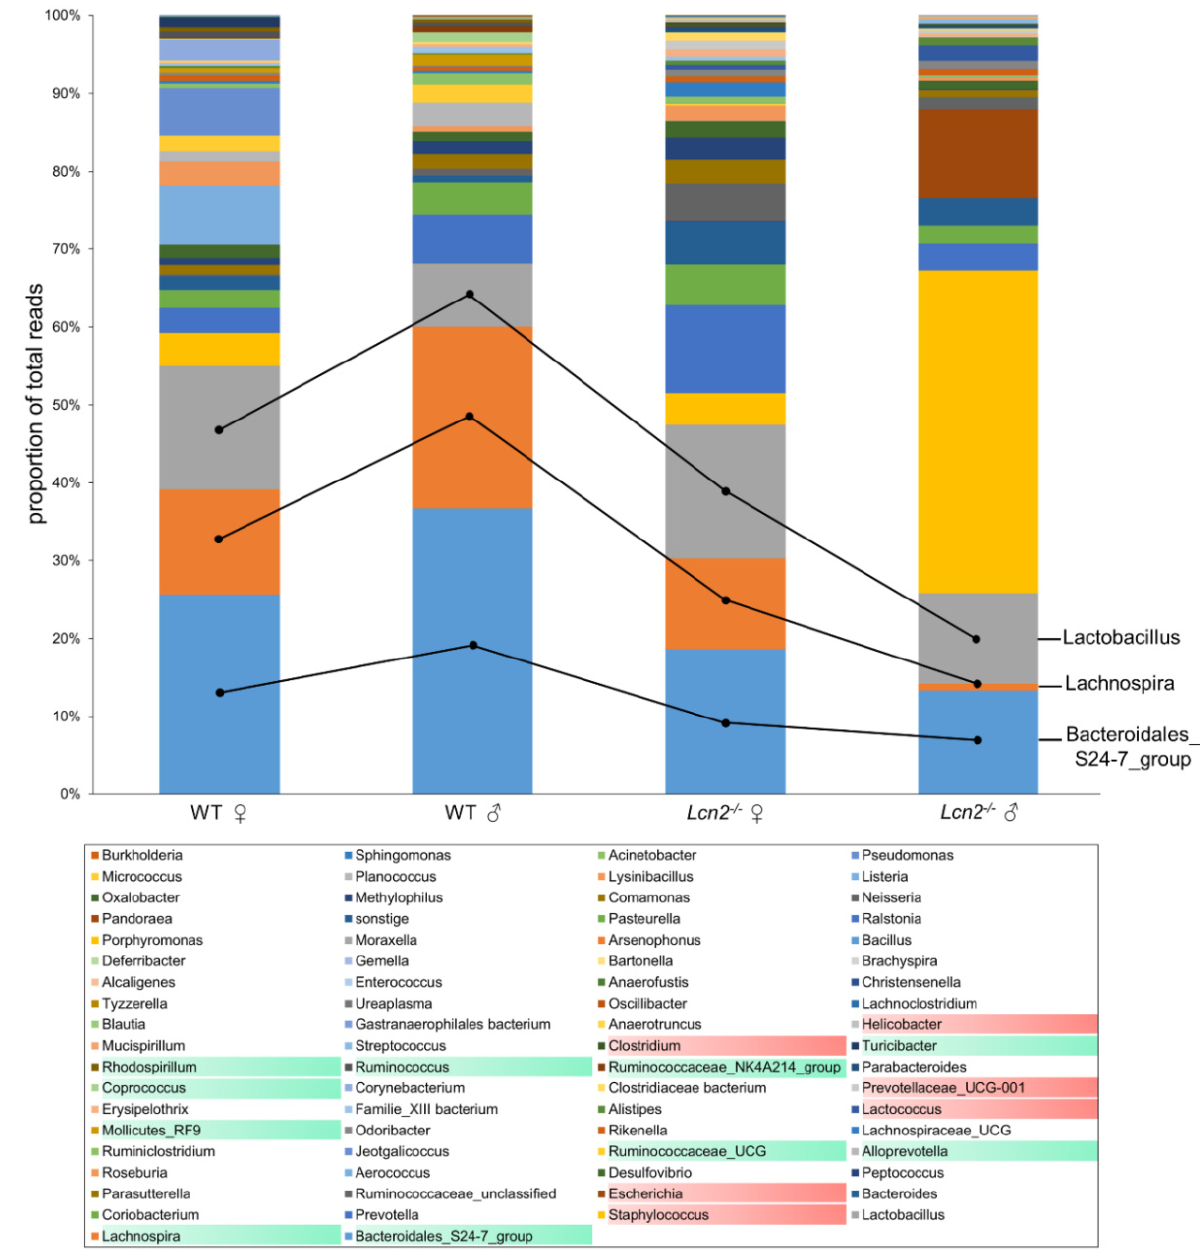
Figure 5. Relative abundance and distribution of identified genera of the intestinal microbiome of Lcn2 -/- and wild type mice. The mean of the relative abundance of genera is plotted groupwise as a percentage of total reads [%]. Genus depicted on a green or red background showed significant differences in WT and Lcn2 -/- mice ( green : decrease or missing in Lcn2 -/- ; red : missing in WT or increased in Lcn2 -/- ). The reading direction begins with the Bacteroidales_S24-7_group and is shown as an example using the first three taxonomic units in the bar chart.